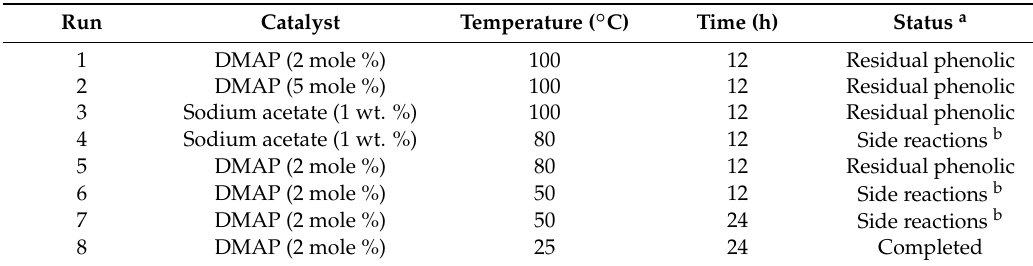
Table 1. Effect of reaction conditions on the status of reaction for P1–MMA synthesis.